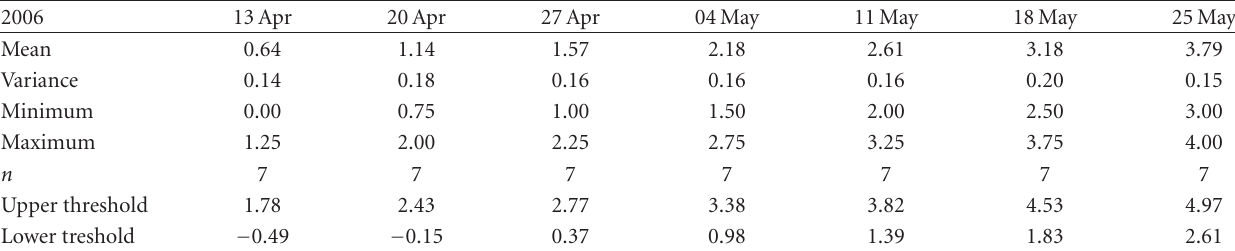
Table 4: Results of Descriptive Analysis. Year